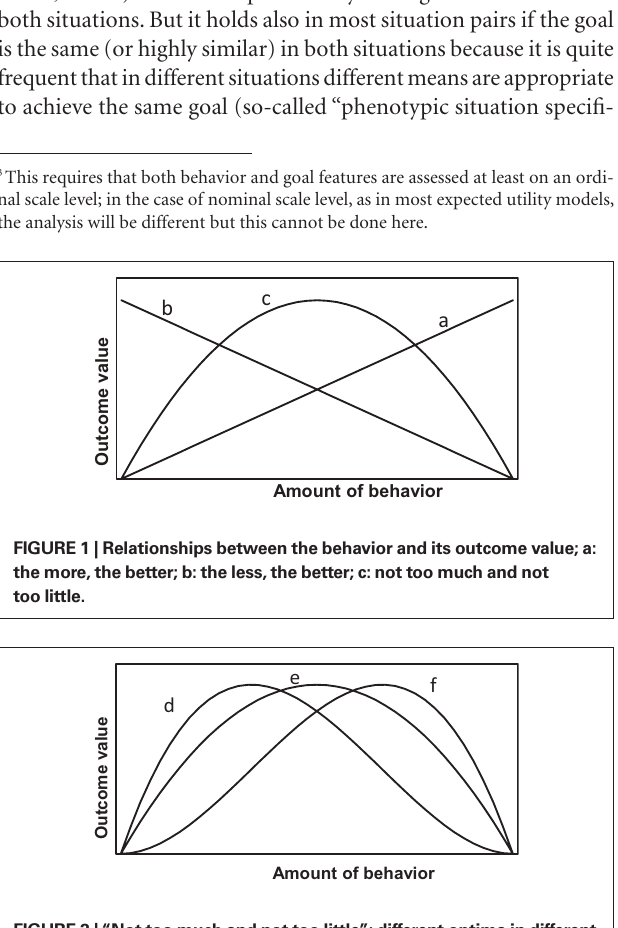
FiGuRe 2 | “Not too much and not too little”: different optima in different situations; d, e, f: different optima.